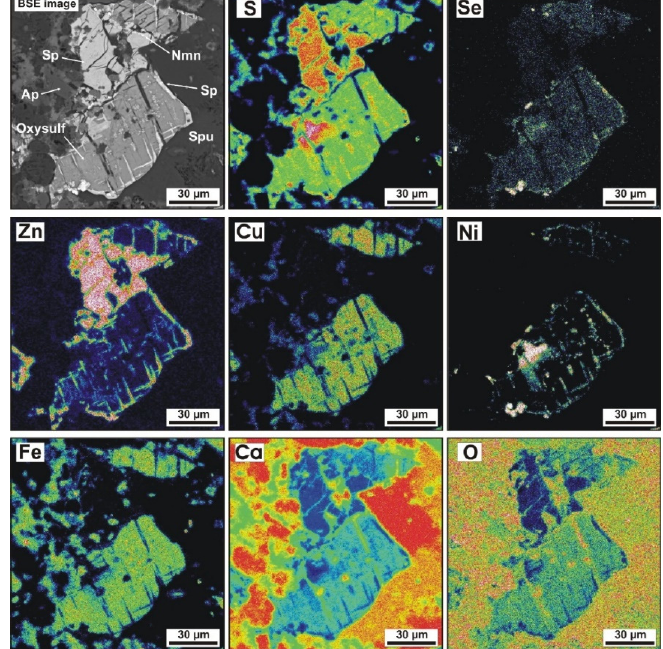
Figure 8. BSE image and elemental maps (S, Se, Zn, Cu, Ni, Fe, Ca, O) showing sphalerite coexisting with complex Fe-Ca-Cu-S-O-Se-bearing compounds. Sample DT-25. Ap = fluorapatite, Cal = calcite, Nmn = naumannite, Oxysulf = complex Ca-Fe-Cu-S-Se-O compounds (oxychalcogenides?), Sp = sphalerite, Spu = spurrite.